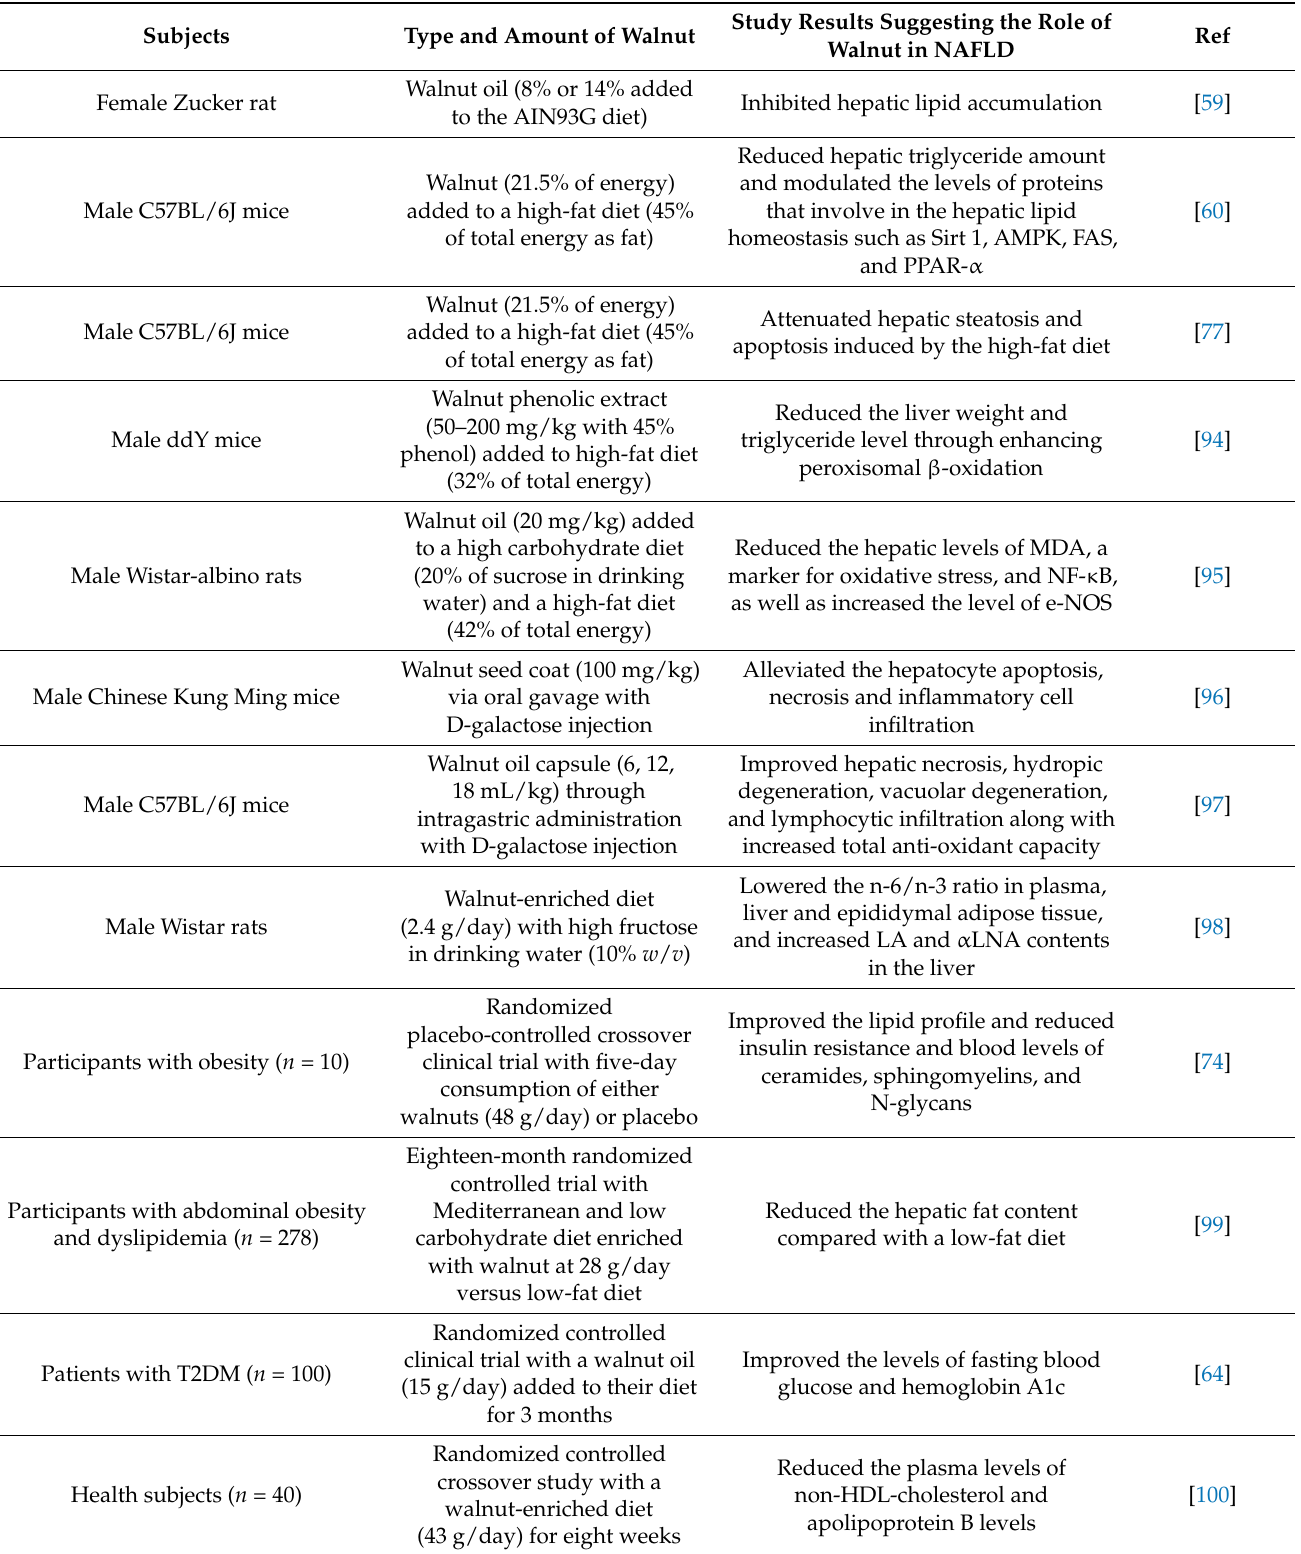
Table 3. Animal and human intervention studies explored the effects of walnut on NAFLD and NAFLD-associated metabolic